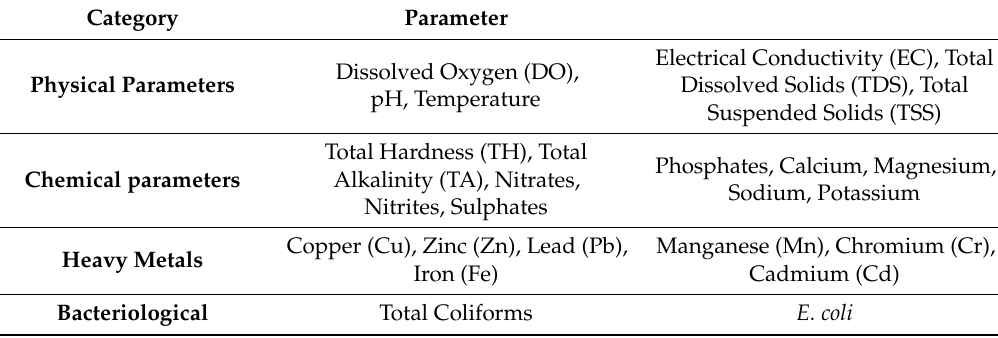
Table 1. Water quality parameters of